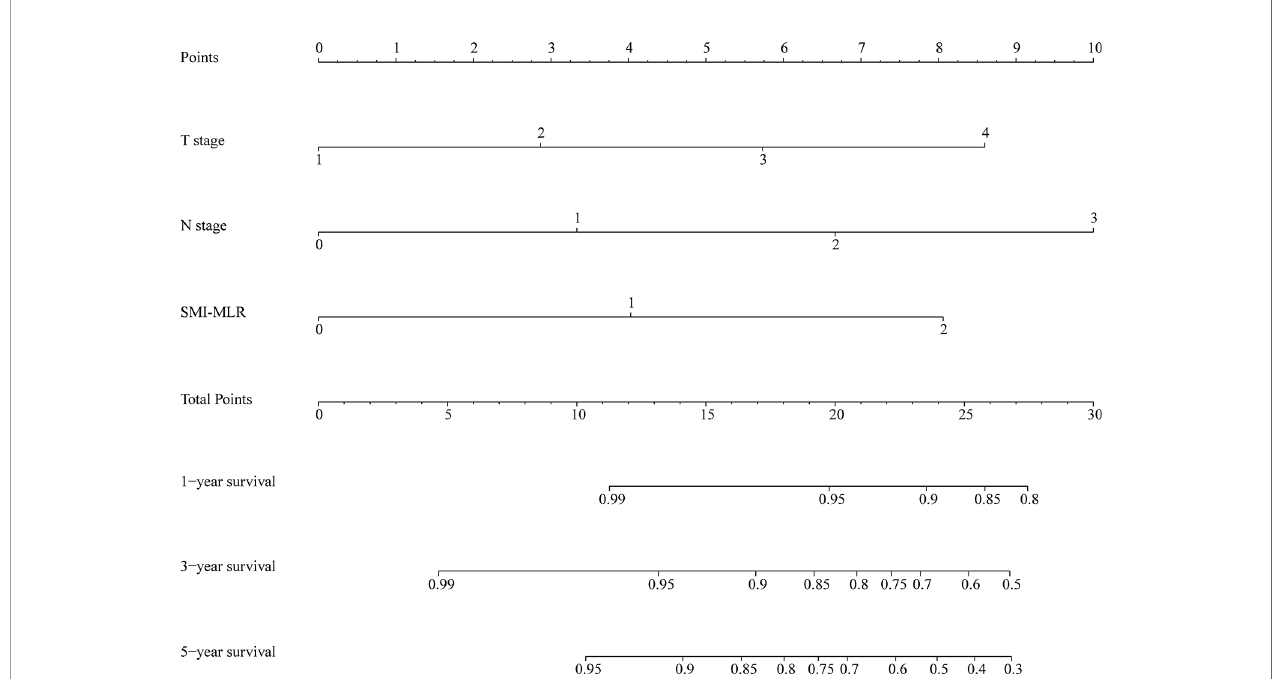
FIGURE 2 | Nomogram to predict 1-, 3-, and 5-year overall survival generated using the training set.